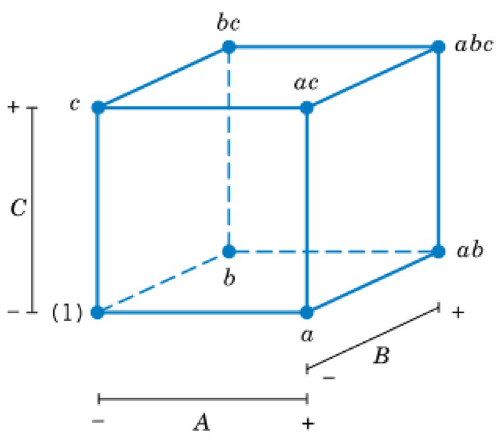
Figure 5. Geometric representation of the 2 3 experimental design.